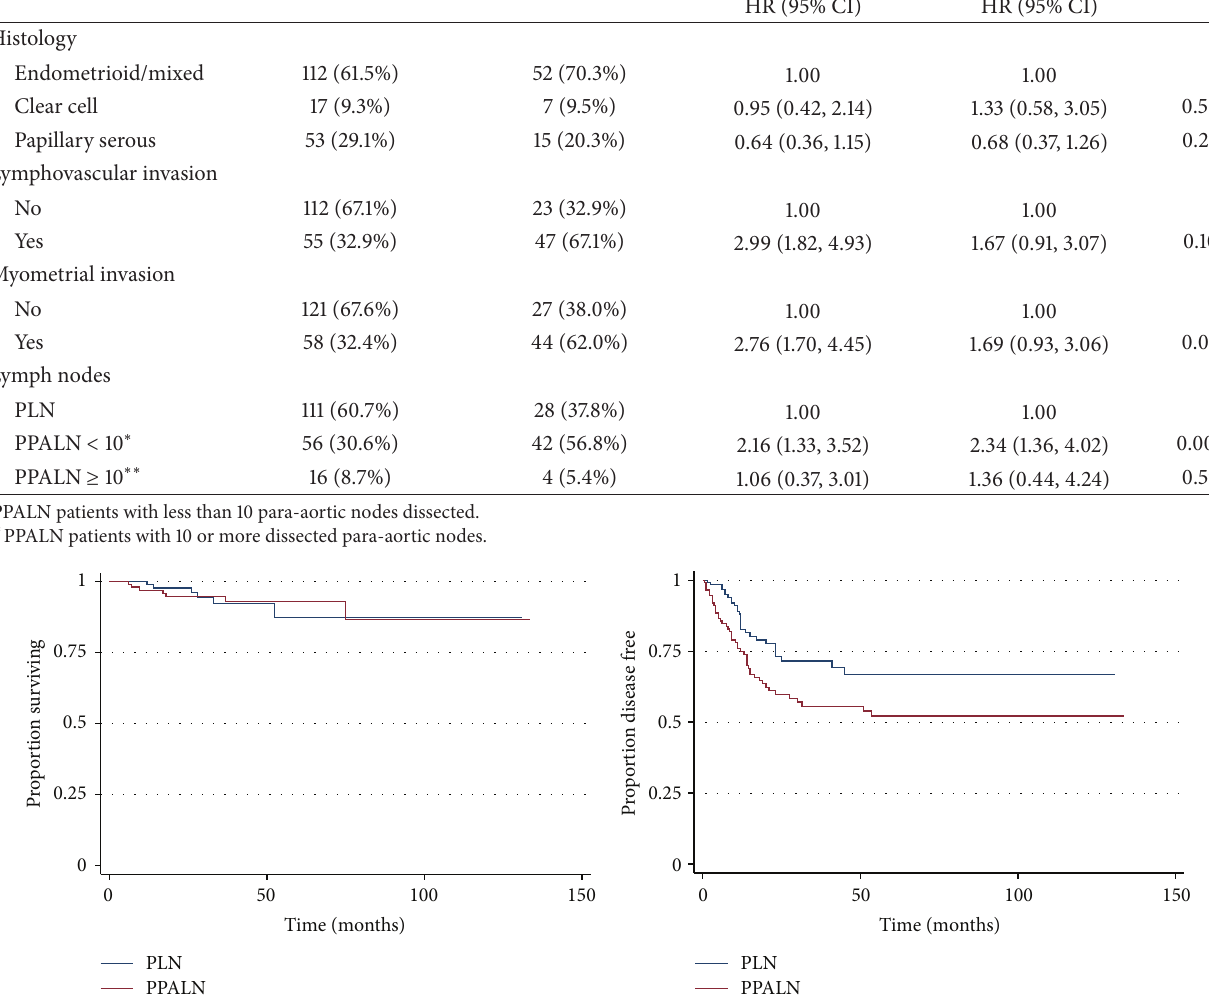
Table 2: Disease-free survival analysis adjusting for the following variables: tumor histology, lymphovascular invasion, myometrial invasion, and number of para-aortic lymph nodes.